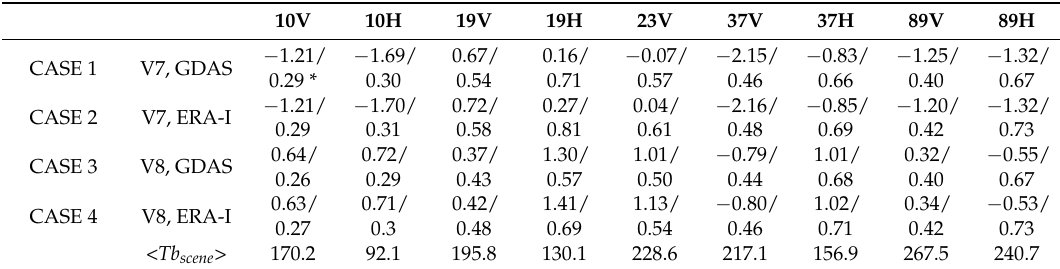
Table 2. Double Differences Mean and